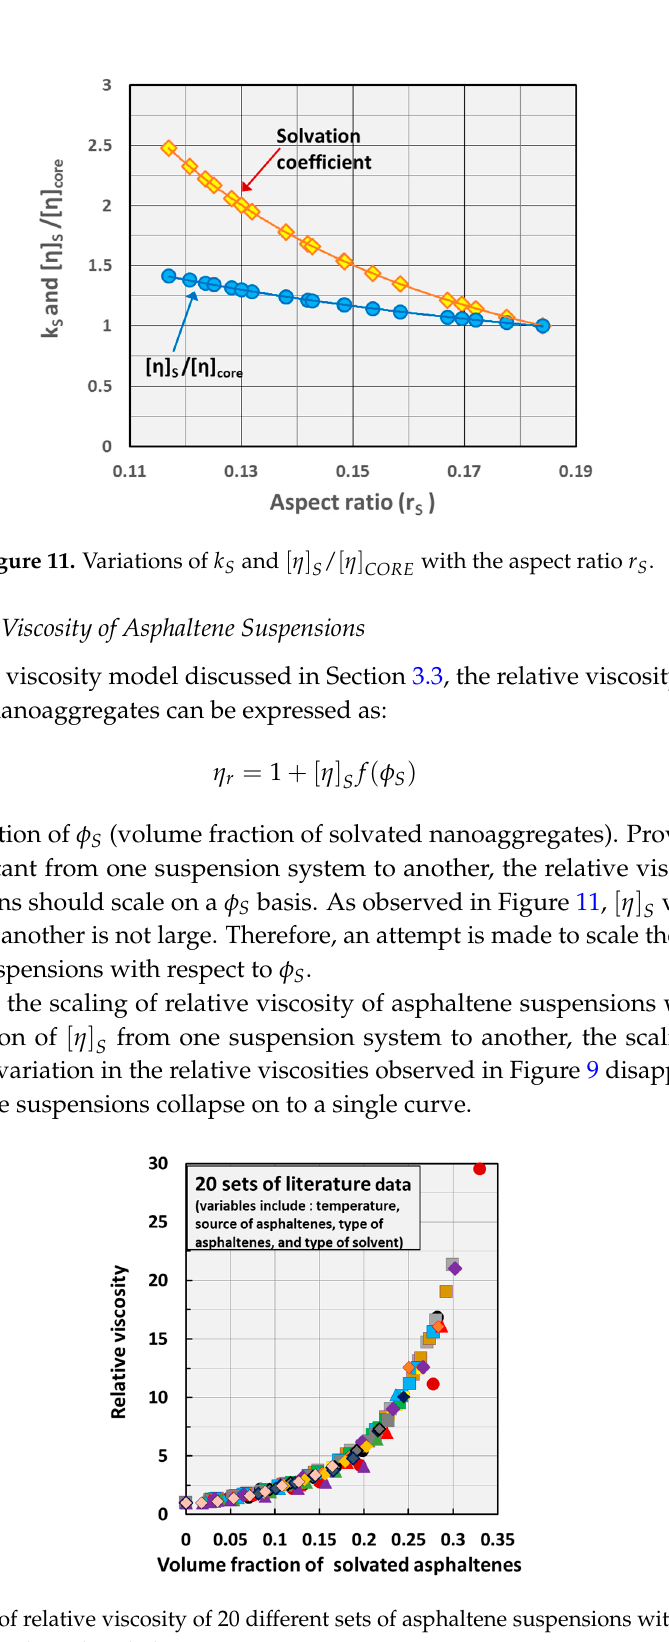
Figure 10. Estimation of virial coefficient B of asphaltene suspensions.